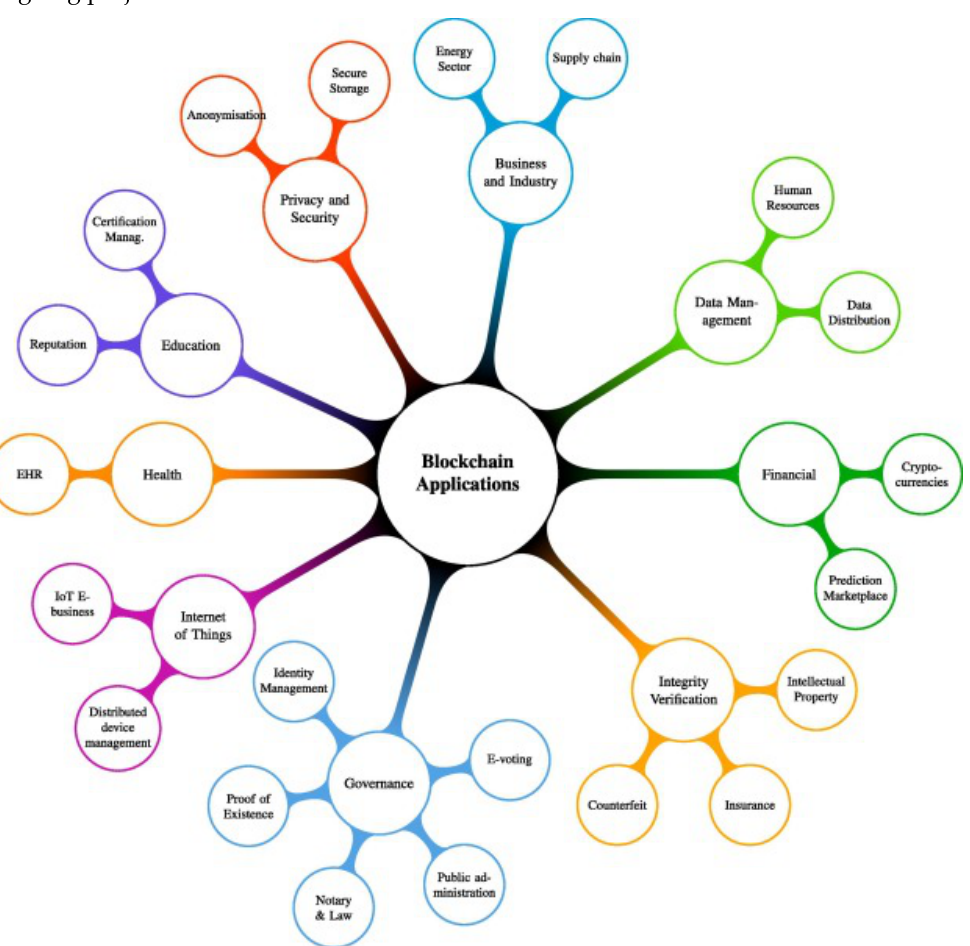
Figure 6. Applications of blockchain in ongoing